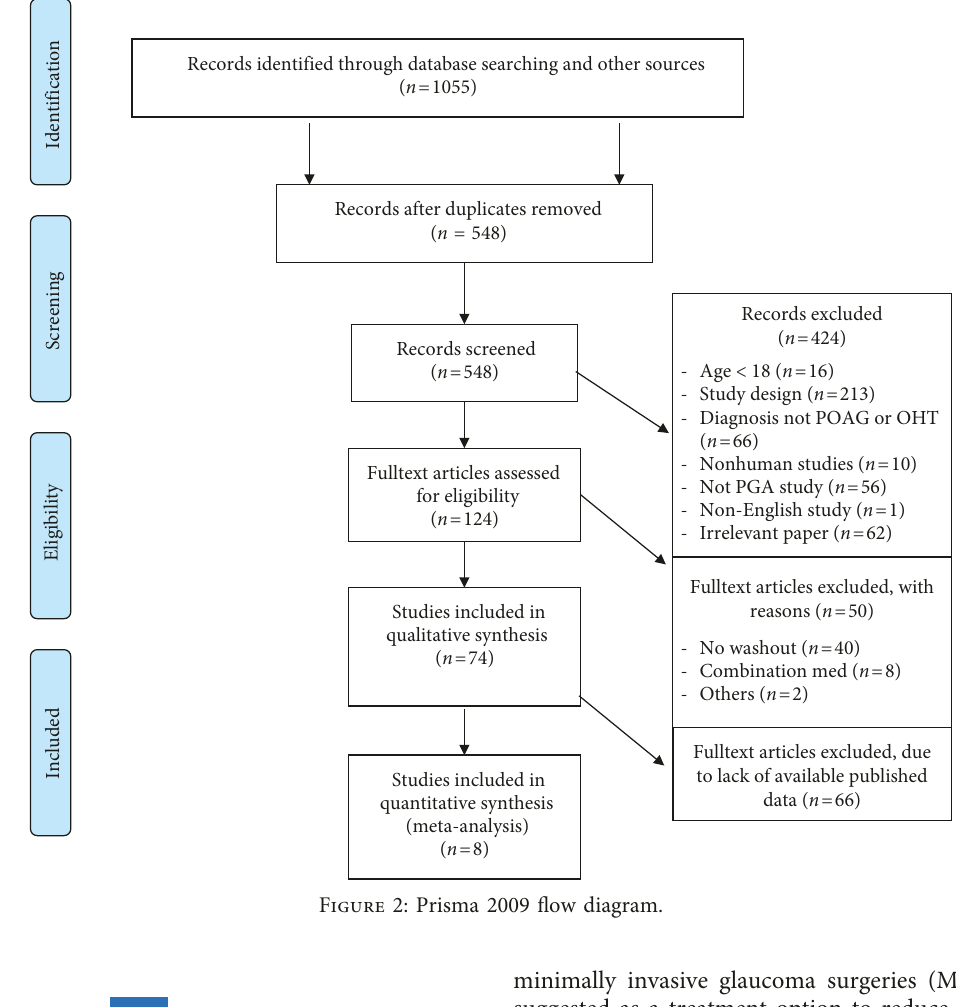
Figure 2: Prisma 2009 flow diagram.